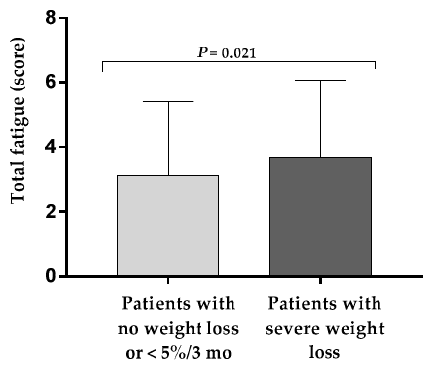
Figure 1. Total fatigue score according to self-reported severe weight loss at hospital discharge. The column plot represents mean and SD.